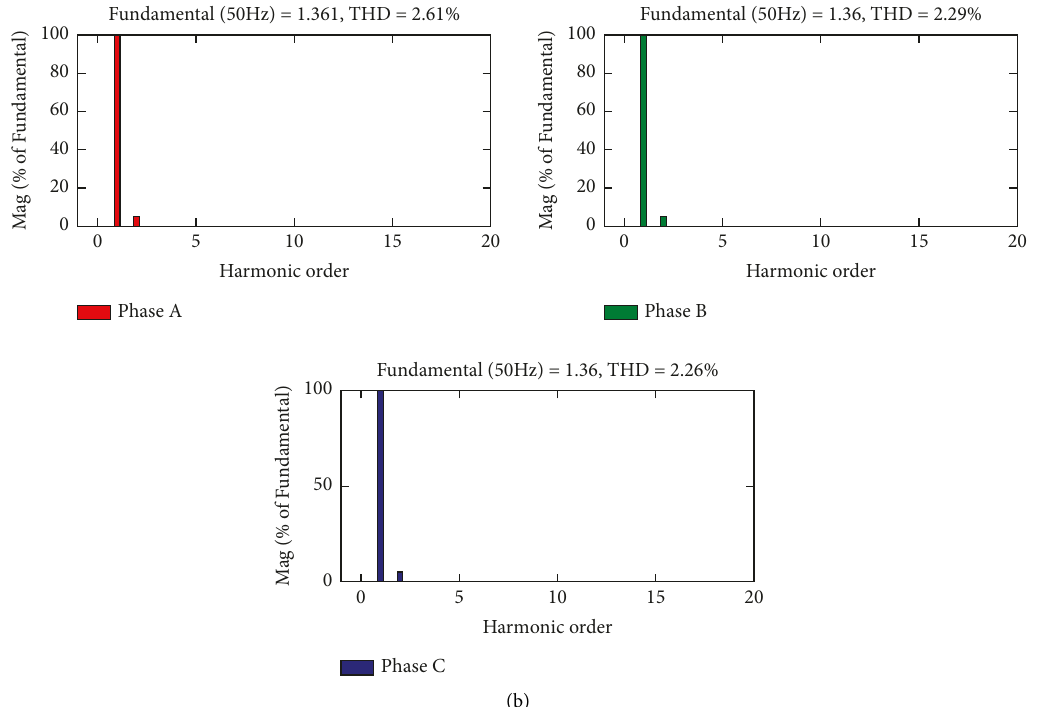
Figure 19: THD spectrum of the source current before and after interconnection of PV-SHAPF. (a) Spectrum of THD of the source current prior to the connecting of PV -SHAPF. (b) After the connecting of PV-SHAPF, the THD spectrum of the source